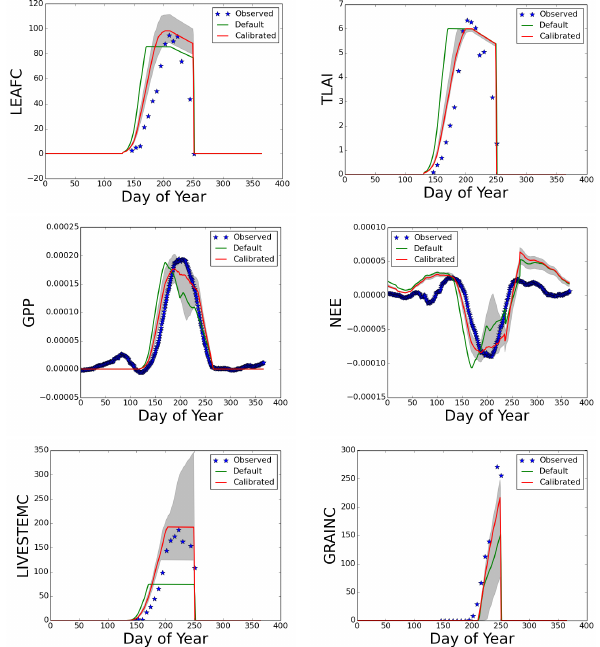
Figure 6. Validation experiment (Bondville, IL): comparison of the observed data for 2002 with the model. The grey areas correspond to 95% confidence error bars.